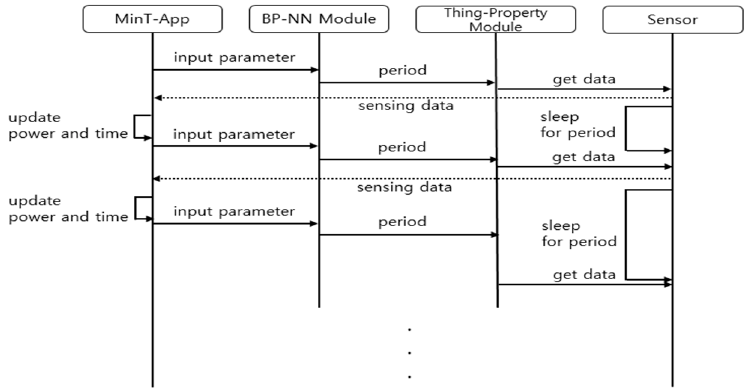
Figure 5. Sequence diagram for sensing period control.